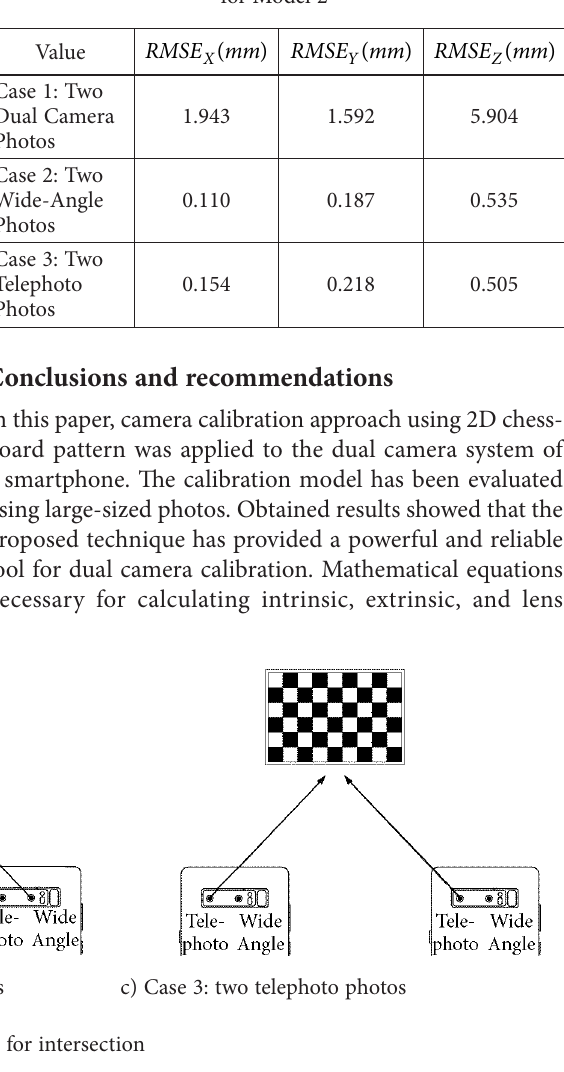
Table 6. Results for the 40 node points of chessboard pattern